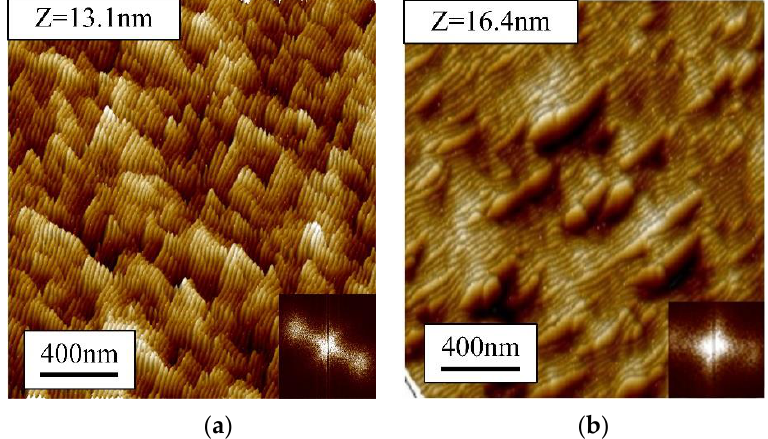
Figure 4. AFM topography of sapphire sputtered with or without Fe assisted Ar ion beam, at an incident angle 65°, incident energy 1000 eV, beam density 487 μA/cm 2 , duration time 60 min. ( a ) patterns bombarded with a pure ion beam ( b ) patterns bombarded with simultaneous Fe co-deposition and taken at a position 2 cm from the Fe target. Top-left and bottom-right insets show the corresponding longitudinal height and Fourier transform, respectively.